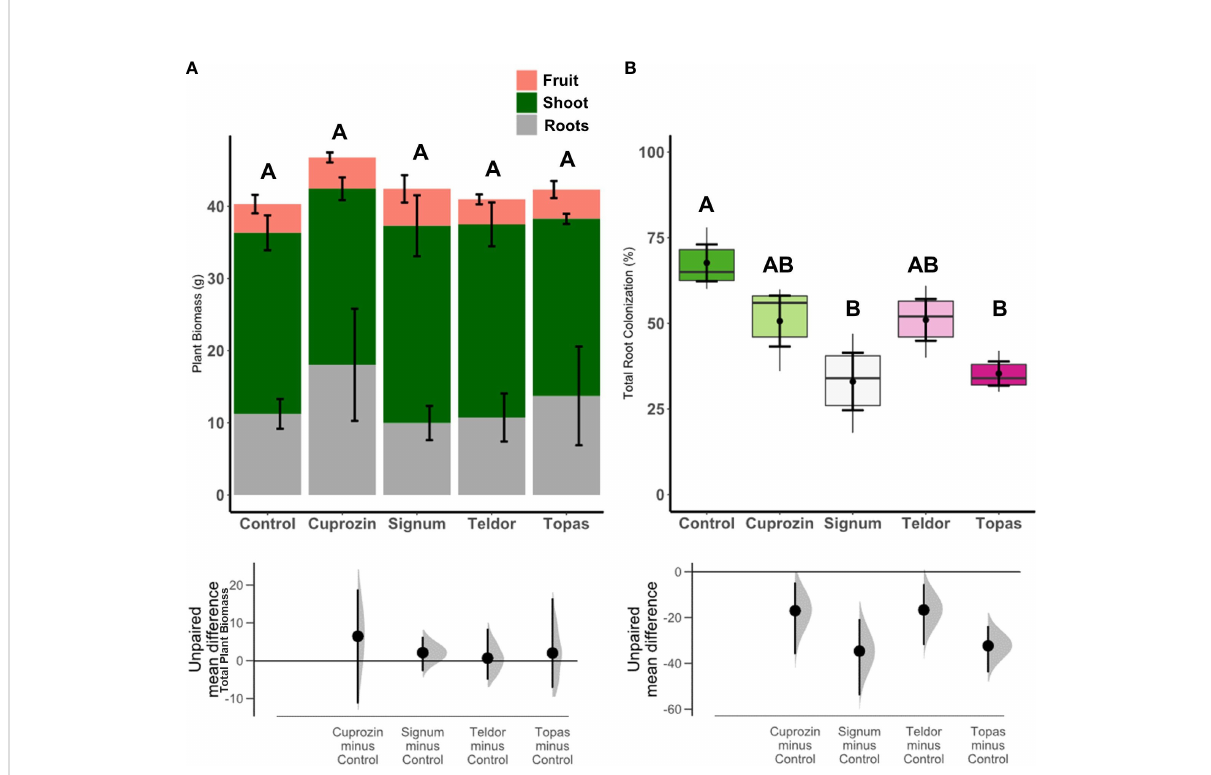
FIGURE 1 Tomato plant biomass and root colonization analyzed after 90 days of growth including: total biomass (A) and total root colonization (B) . The upper part of the fi gures are represented by stacked bar plots with the biomass partitioning (in fruits, shoot and roots) for the plant biomass (A) , and box-plots containing the average values and standard errors for the root colonization (B) . Treatments with the same letter for each variable are not statistically signi fi cant by the Tukey post-hoc test (p < 0.05, details of ANOVA model are in Supplementary Material). There was no statistically signi fi cant difference for the biomass partitioning between treatments, so statistics are only reported for the total plant biomass. The bottom part of the fi gure are the effect sizes of the treatments in relation to the